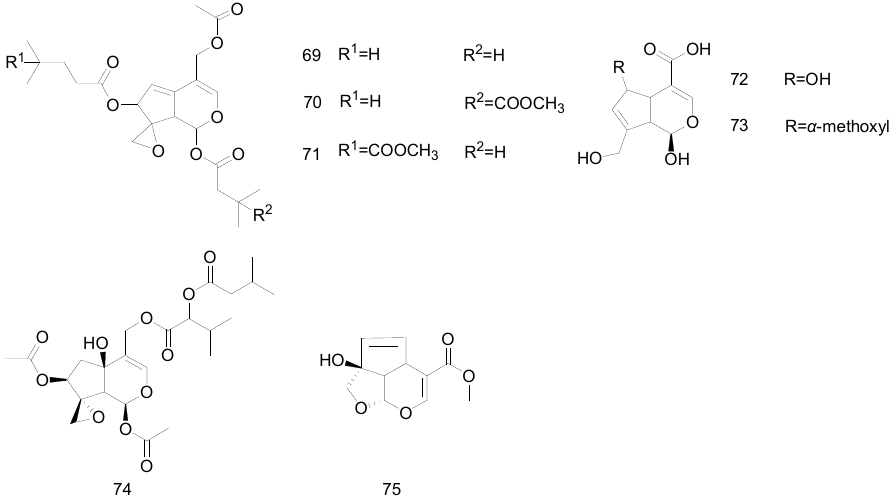
Figure 5. Chemical structures of non-glycosidic iridoids.